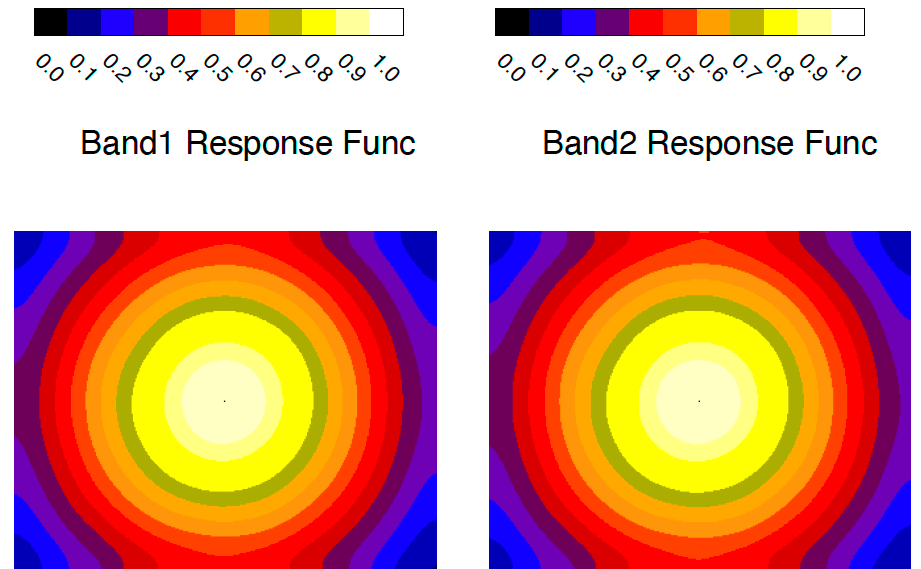
Figure A2. CTI spatial response functions for band1 and band2, showing the vignetting effect of the CTI telescope. The patterns were derived from the 1 November 2019 data as the linear regression coefficients between the center and the other pixels on the detector array.